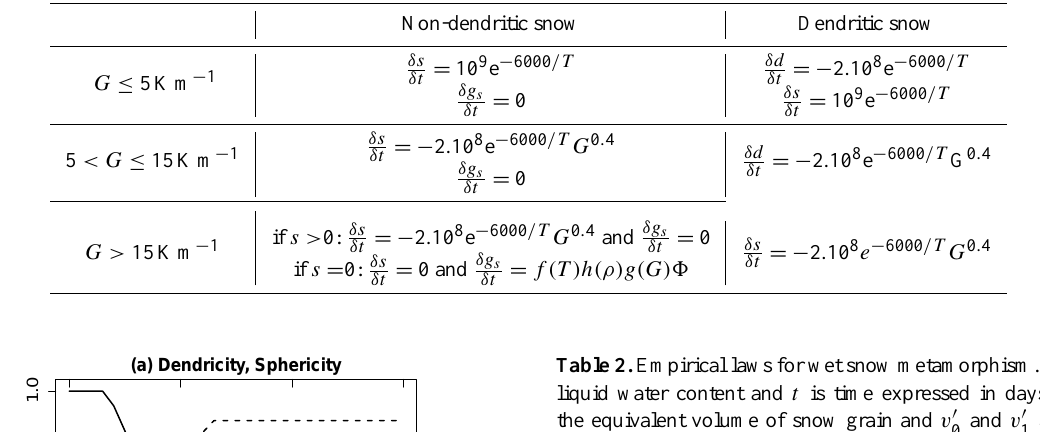
and v 0 are empirical 0 1